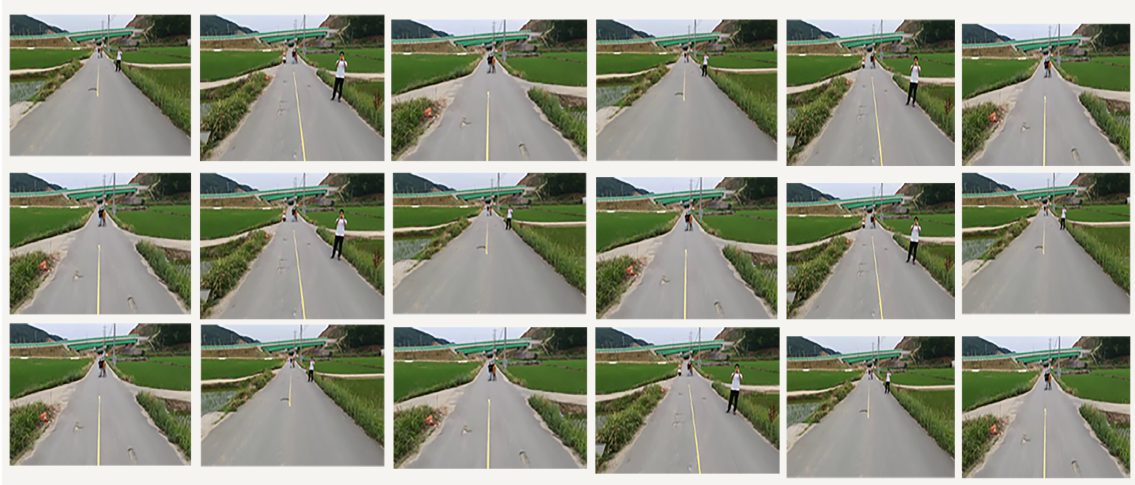
Figure 8. Some preliminary images from the own created dataset for the